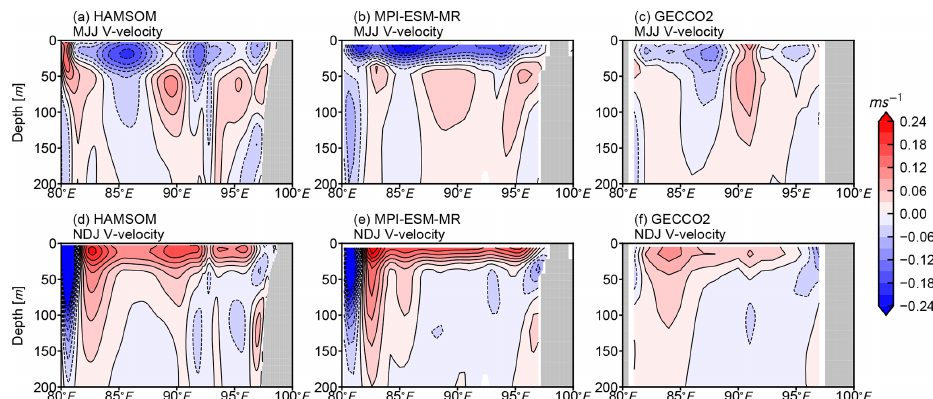
Figure 4. Depth–longitude section of climatological V velocity (averaged over 10 to 12 ◦ N) during MJJ (a, b, c) and NDJ (d, e, f) from HAMSOM, MPI-ESM-MR, and GECCO2, respectively. The contour intervals are 0.03ms − 1 .